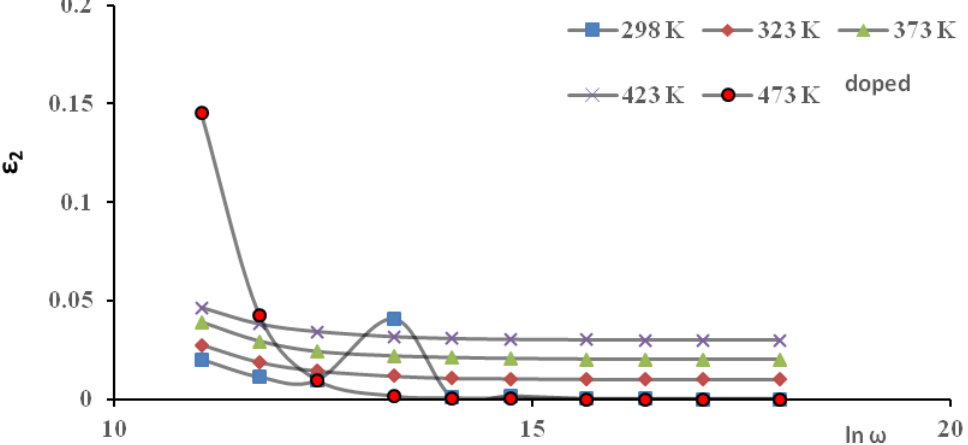
Fig. 7: The variation of (ε ) with ln(ω) for doped ZnS:Pb thin films treated at different 2